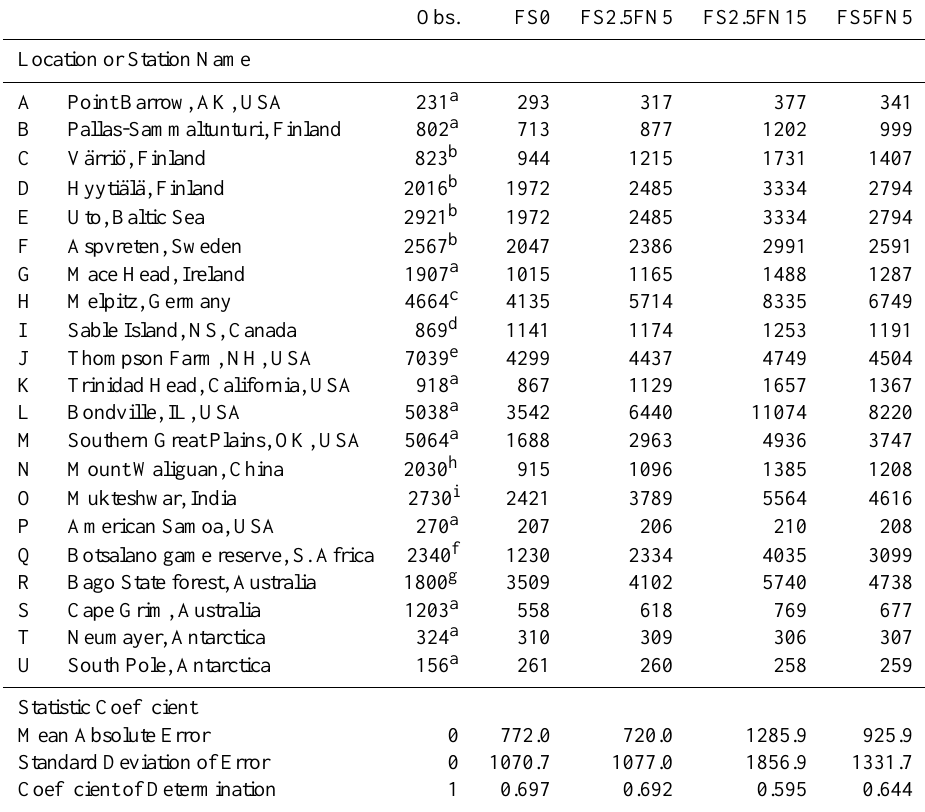
Table 2. Mean number concentrations of condensation nuclei larger than 10nm (CN10) measured in 21 surface stations around the globe. The simulated values for the FS0, FS2.5FN5, FS2.5FN15, and FS5FN5 sensitivity study cases are from the corresponding locations in